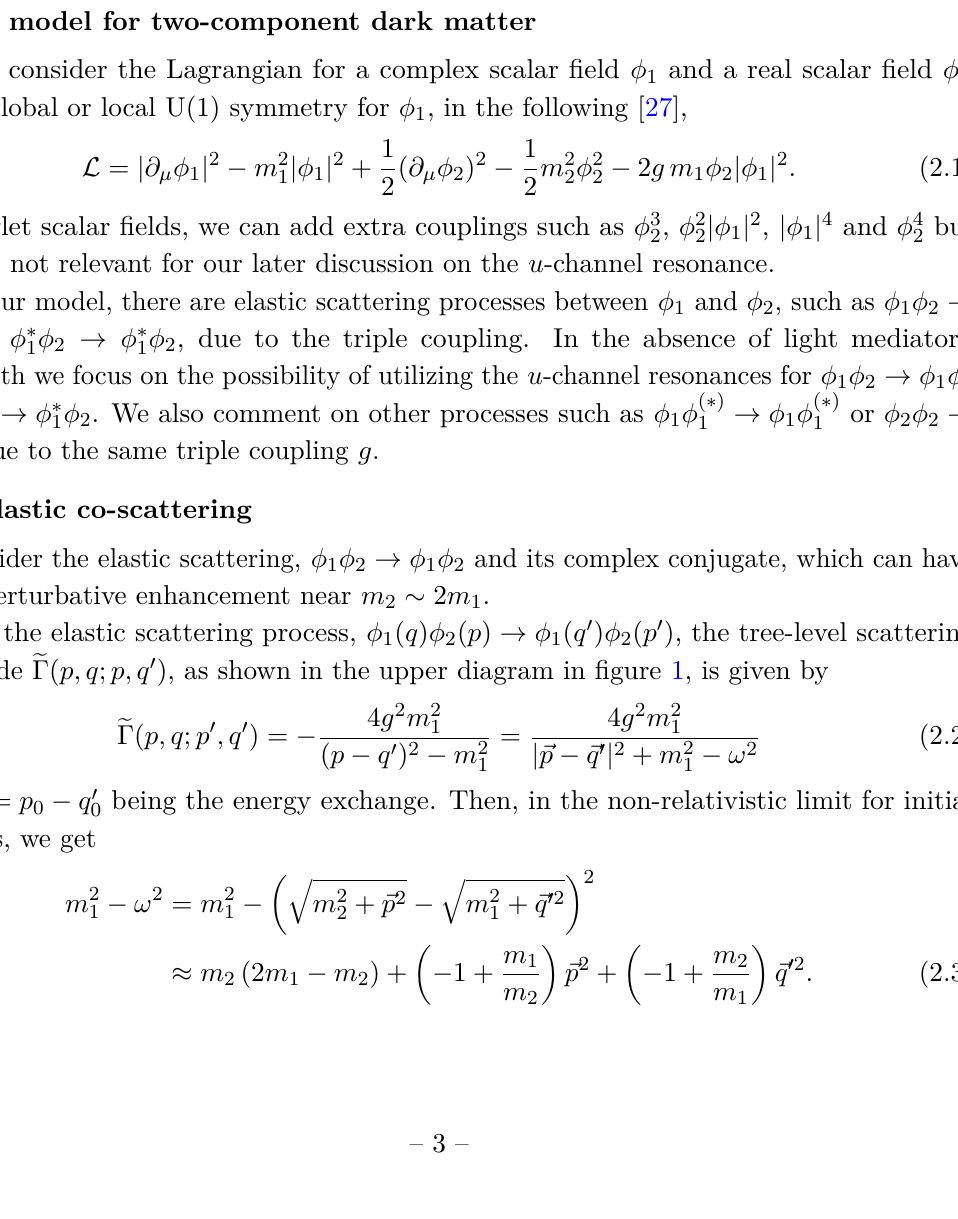
Figure 1 . Feynman diagrams ( u -channel) for φ 1 φ 2 sponding ladder diagrams